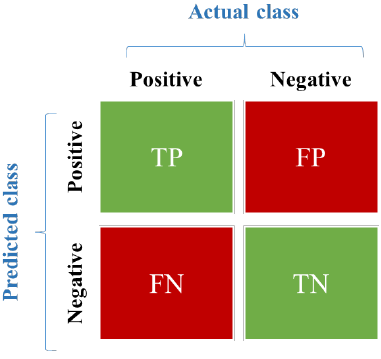
Figure 2. Confusion matrix.